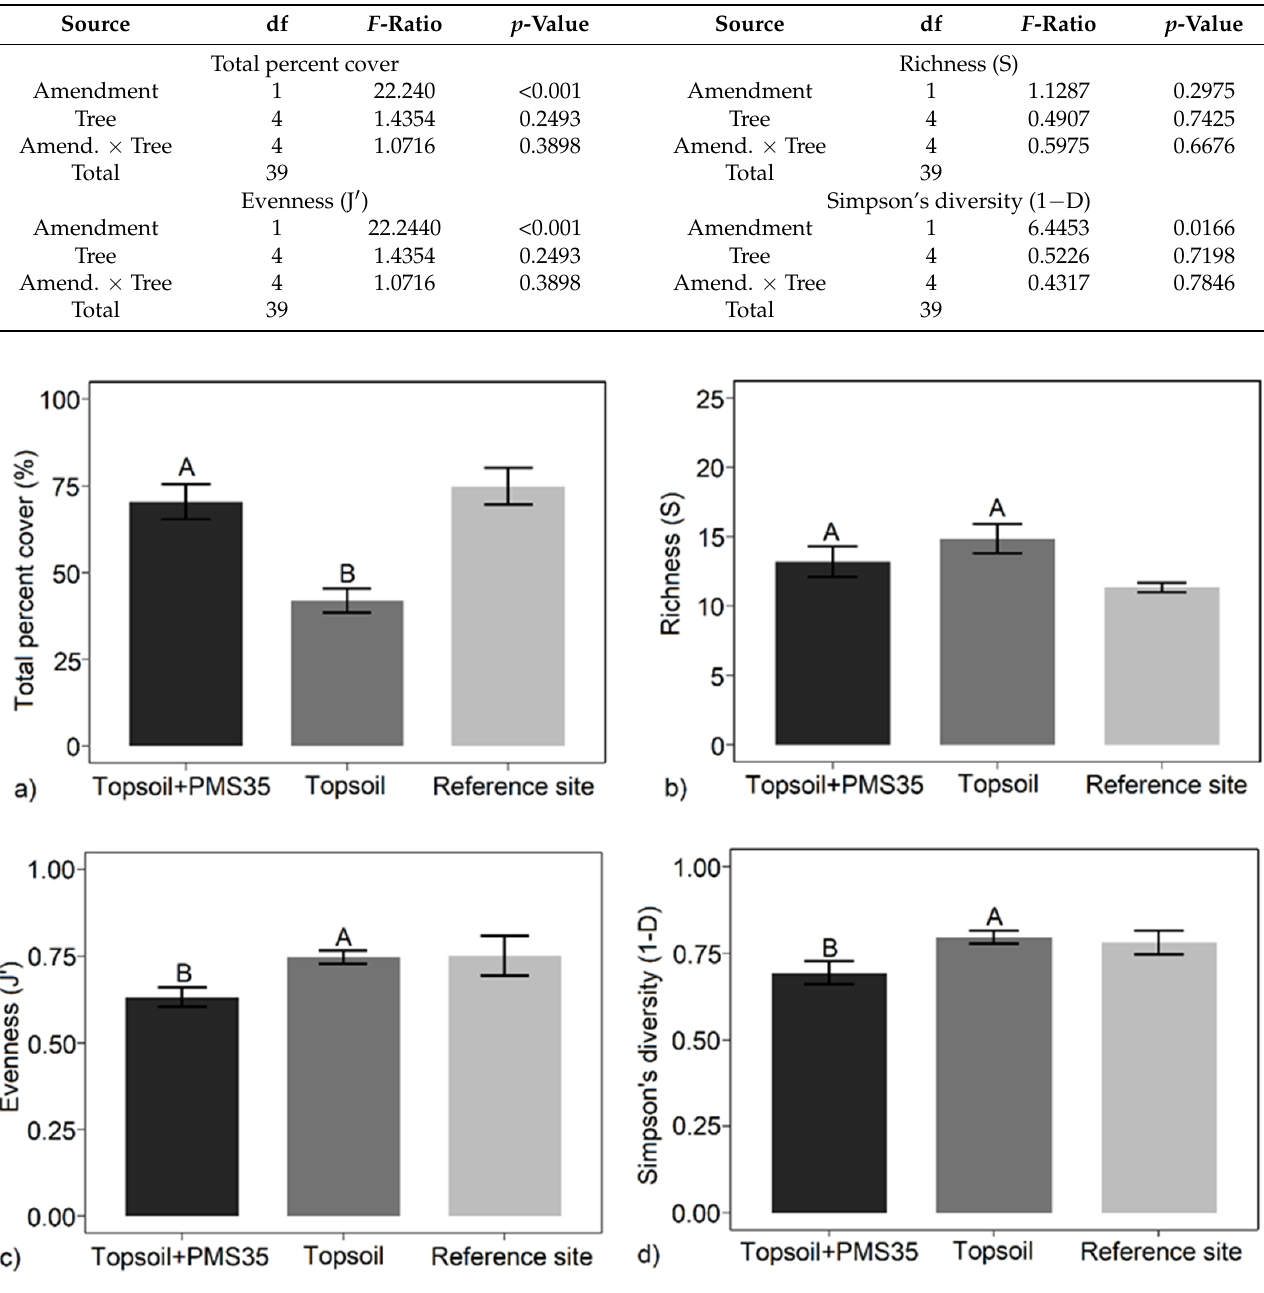
Table 2. Summary of two-way ANOVA of the effect of amendments (topsoil+PMS35 and topsoil) and tree plantations ( L. laricina, P. resinosa , and B. papyrifera , a mixture of these tree species, and the no plantation control) on total percent cover, richness (S), Pielou’s evenness (J (cid:48) ), and Simpson’s diversity index (1 − D) at Niobec.